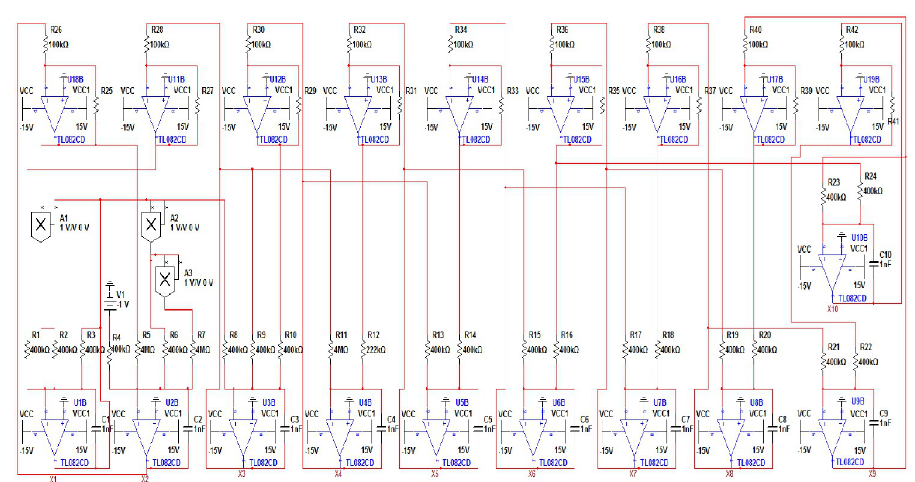
Fig 21. Electronic circuit schematic of the proposed 10-D hyperchaotic system (1).